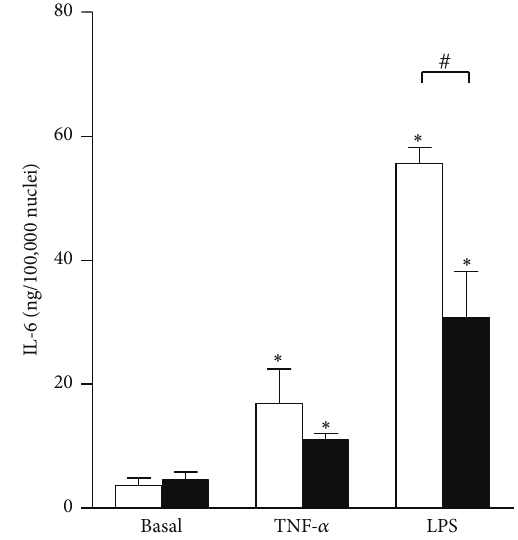
Figure 1: IL-6 secretion from cultured skeletal muscle cells is increased after removal of TNF- 𝛼 and LPS treatment. Human myoblasts (white bars) and myotubes (black bars) were exposed to TNF- 𝛼 (100ng/mL) or LPS (100ng/mL) or vehicle (Basal) for 24 hours. Medium containing TNF- 𝛼 or LPS was removed and replaced with growth medium. IL-6 secretion was estimated by ELISA 24 hours after compound removal. Data are means ± SEM ( n = 4–6). ∗ P < 0.05 versus respective Basal. # P < 0.05 myoblasts versus myotubes (95% confidence interval (CI) of difference: − 39.96 to −